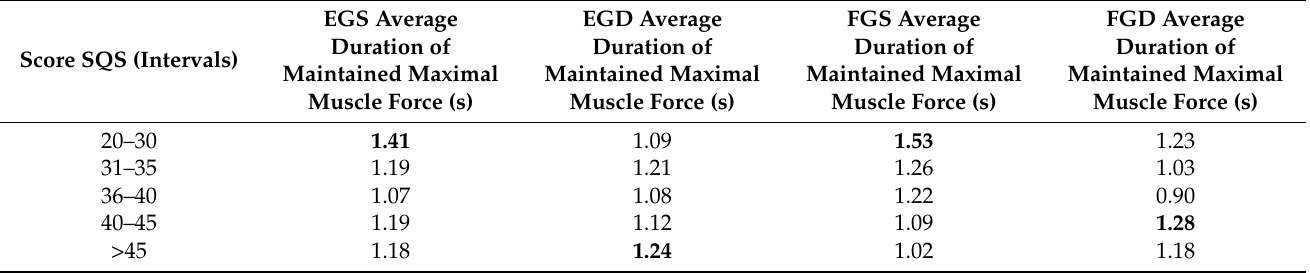
Table 13. Correspondence between each SQS score group and average duration of maintained muscle force (knee flexors and knee extensors).